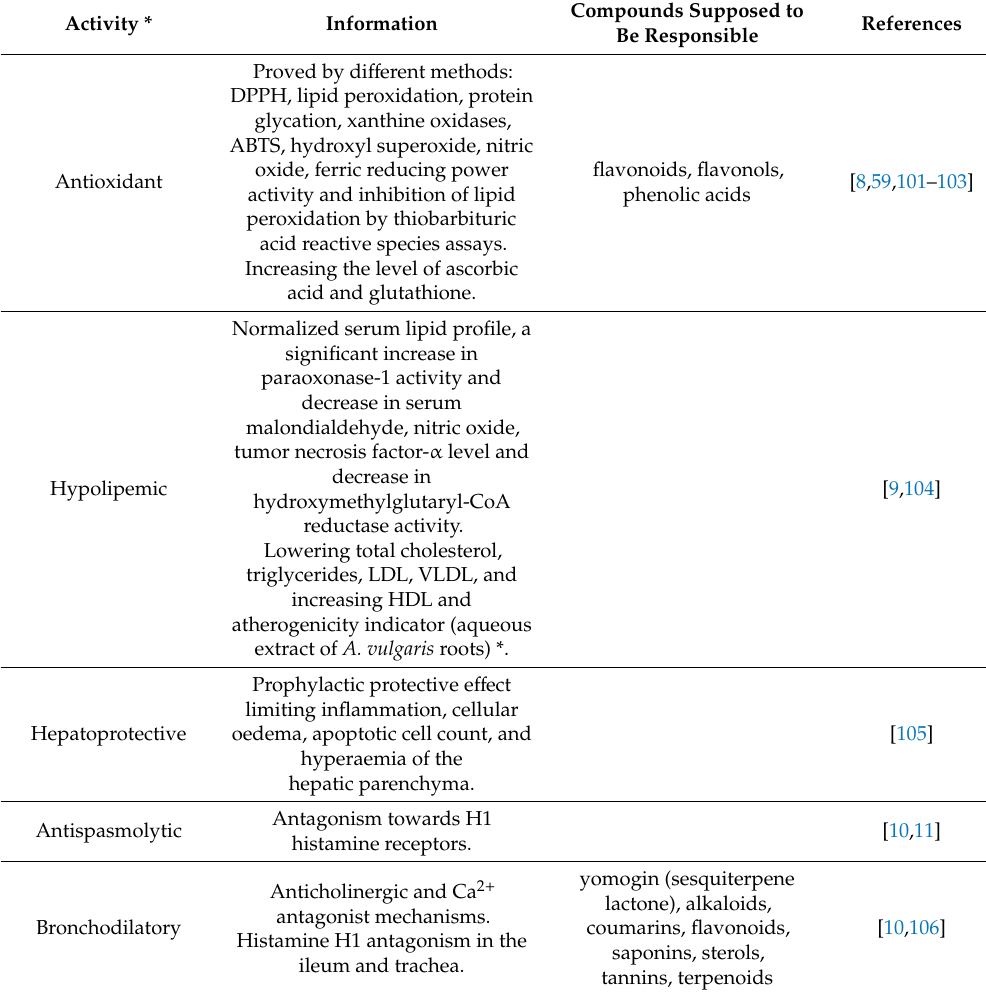
Table 5. Pharmacological properties of A. vulgaris herb and root